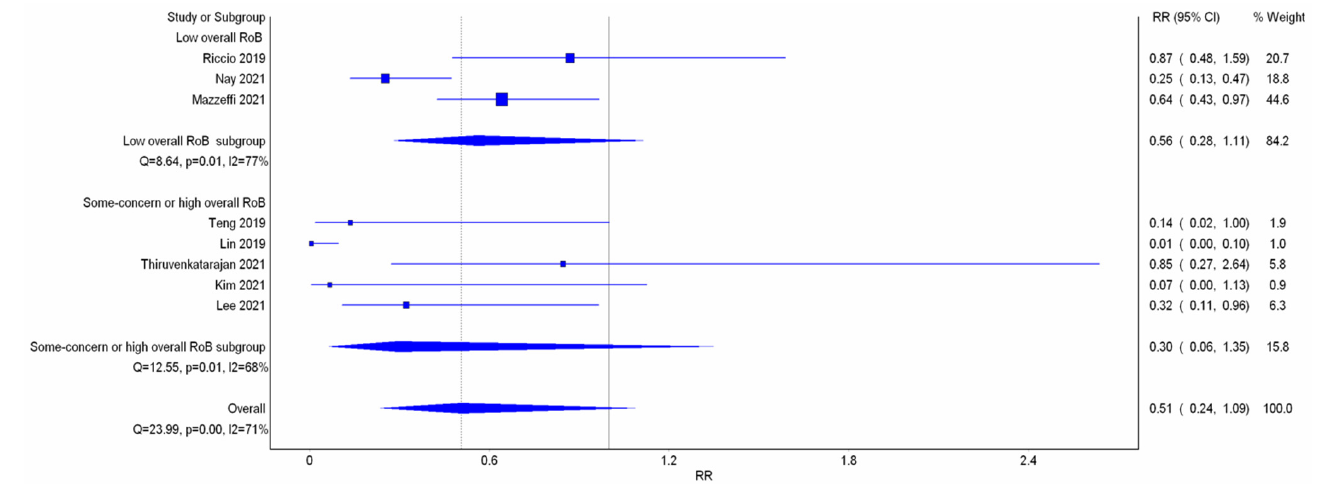
Figure A2. Meta-analysis with IVhet model: incidence of hypoxemia (subgroup analysis with overall risk of bias). Studies included: Riccio et al. [13], Nay et al. [16], Mazzeffi et al. [14], Teng et al. [12], Lin et al. [11], Thiruvenkatarajan et al. [15], Kim et al. [17], Lee et al. [18].